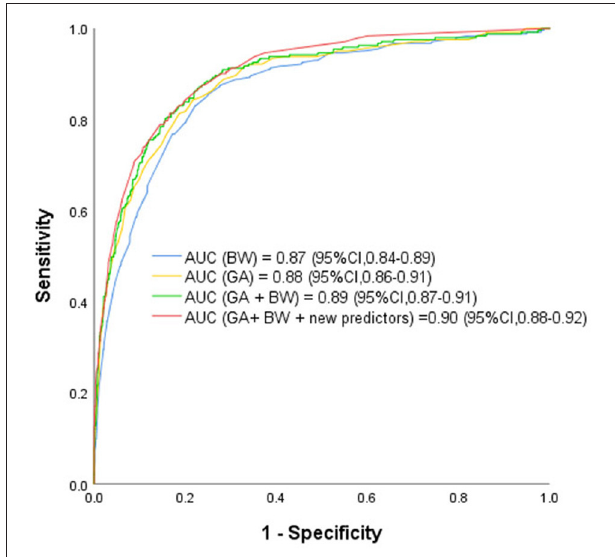
FIGURE 1 | Receiver Operating Characteristic Curves rom the Prediction Models Using Various Combinations of Predictors for Retinopathy of Prematurity Based on the Final Prediction Model. GA, gestational age; BW, birth weight; BT, blood transfusion; IMV, invasive mechanical ventilation; WGR, weight gain rate. The receiver operating characteristic curves from retinopathy of prematurity prediction models using various combinations of predictors including known predictors (birth weight, gestational age, and new predictors (weight gain rate, blood transfusion, invasive mechanical ventilation and NT-proBNP ≥ 25,000 ng/L). AUC indicates area under receiver operating characteristic curve.